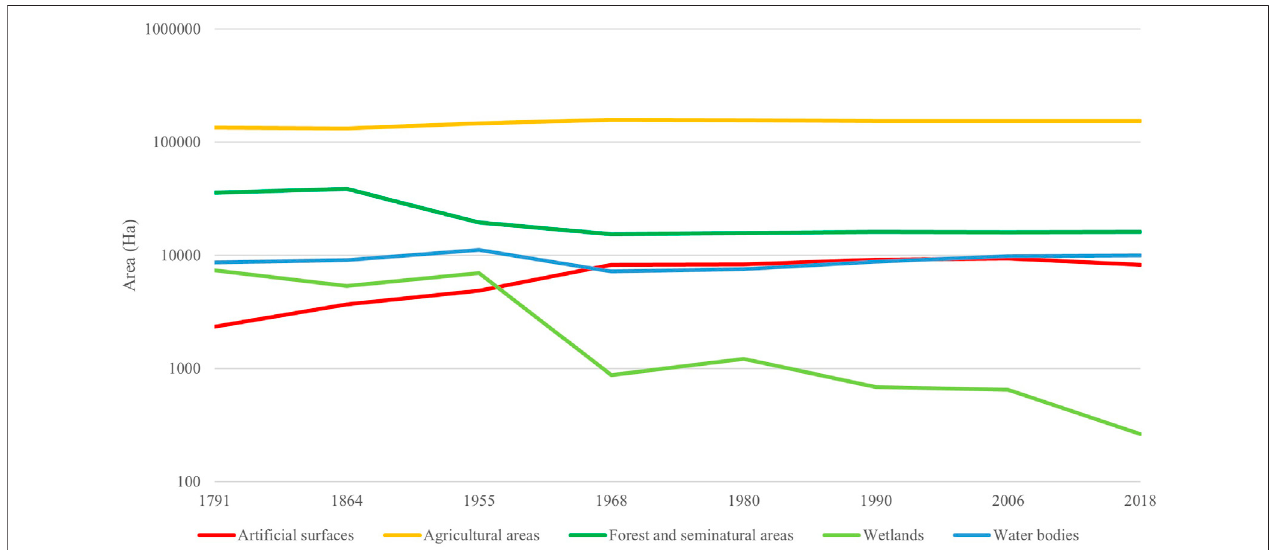
FIGURE 5 | Landscape changes in study area from Mosti ș tea Basin (1791 – 2018). Landscape changes within a ten-km radius.